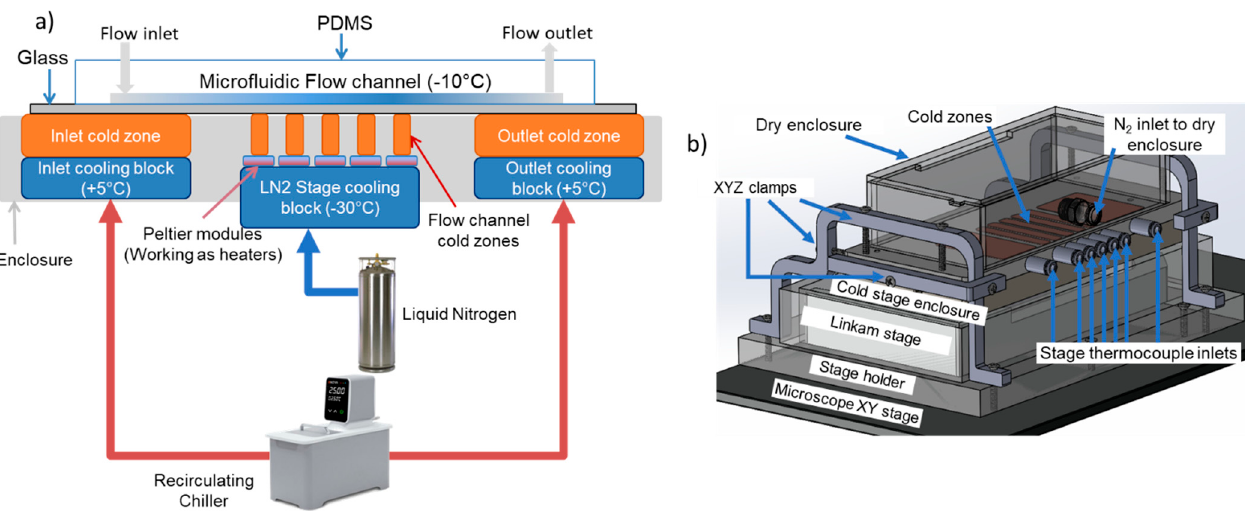
Figure 1. Temperature-controlled microfluidic platform: ( a ) Schematic showing the complete platform with multiple copper blocks for individually controllable cold zones and the cooling blocks underneath which act as heat sinks for the cold zones; ( b ) CAD model showing the platform on a microscope stage with a dry, optically transparent enclosure on top surrounding the region where the microfluidic device is placed.